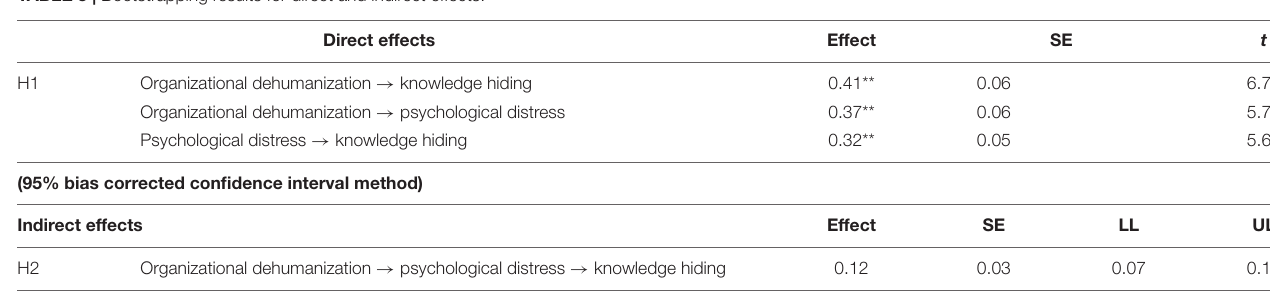
TABLE 3 | Bootstrapping results for direct and indirect